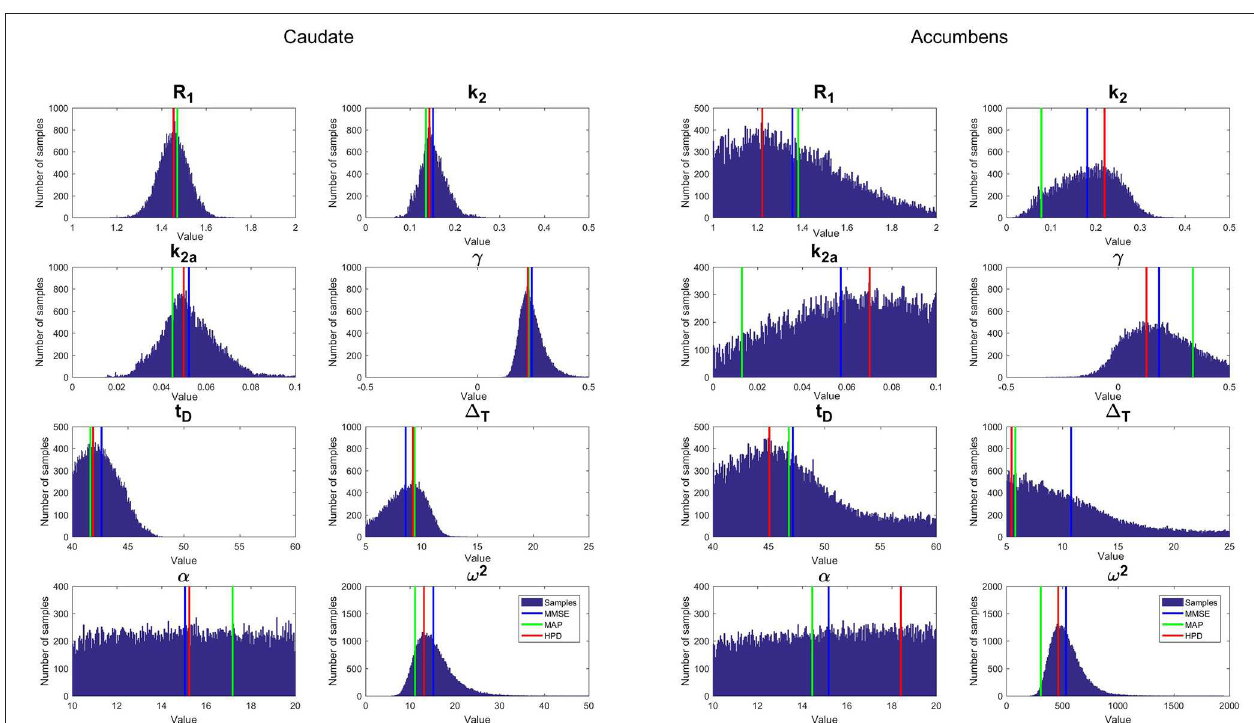
FIGURE 4 | Illustration of the sampling of parameter γ on a single ROI (caudate, condition DR25). (Left) Evolution of the step size during the burn-in phase. (Middle) Generated samples (Markov Chain). The grayed region corresponds to the burn-in phase whose samples are withdrawn. (Right) Histogram of the remaining samples corresponding to the estimation of the marginal distribution of γ .